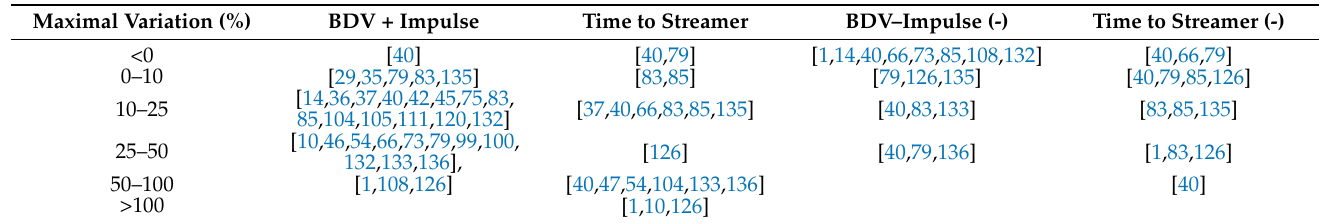
Table 16. Maximal variations of the breakdown voltage and time to breakdown of nanofluids with respect to the base oils in lightning impulse tests.